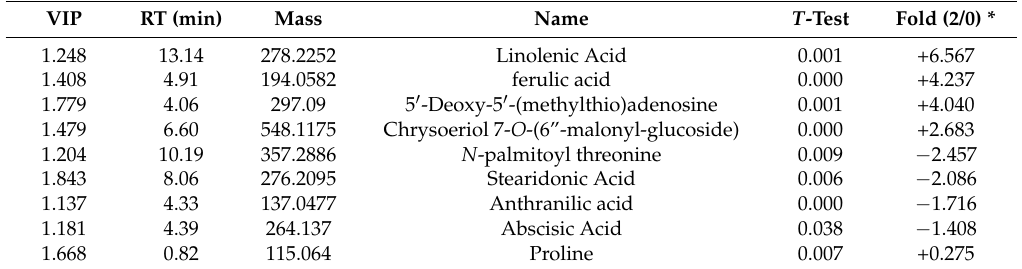
Table 1. The main identification obtained between 0 day and 2 days in ESI+ ( p < 0.05).